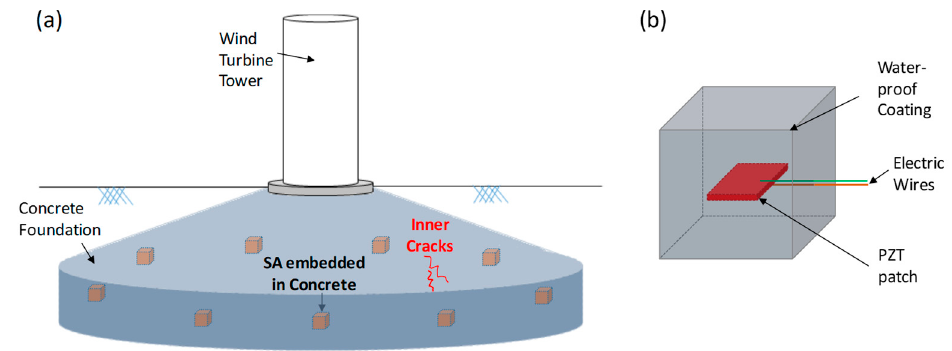
Figure 20. ( a ) Impedance-based SHM of an onshore wind turbine foundation using the SA technique; ( b ) an SA prototype.